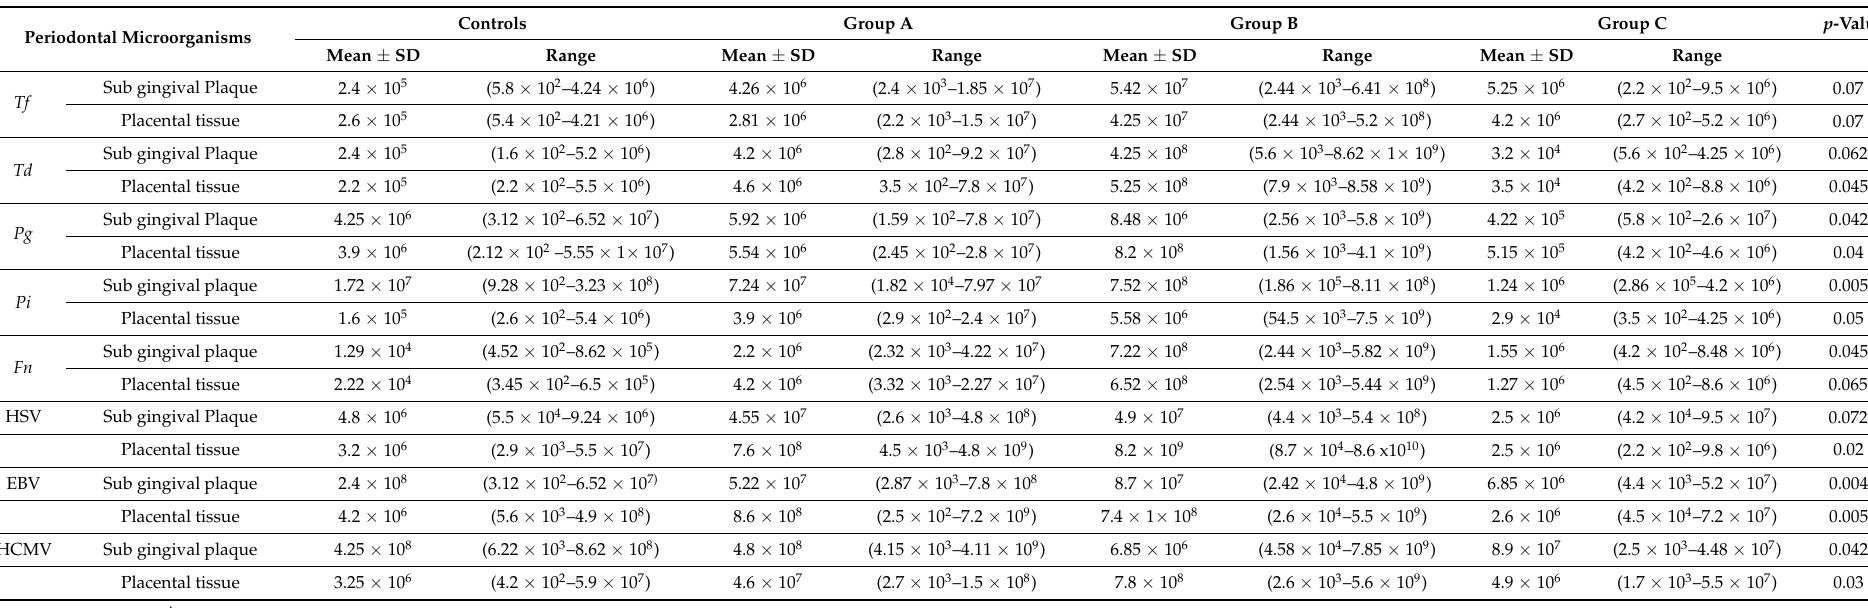
Table 5. Comparison of the presence of bacteria and viruses in subgingival plaque and placental tissue samples in between the